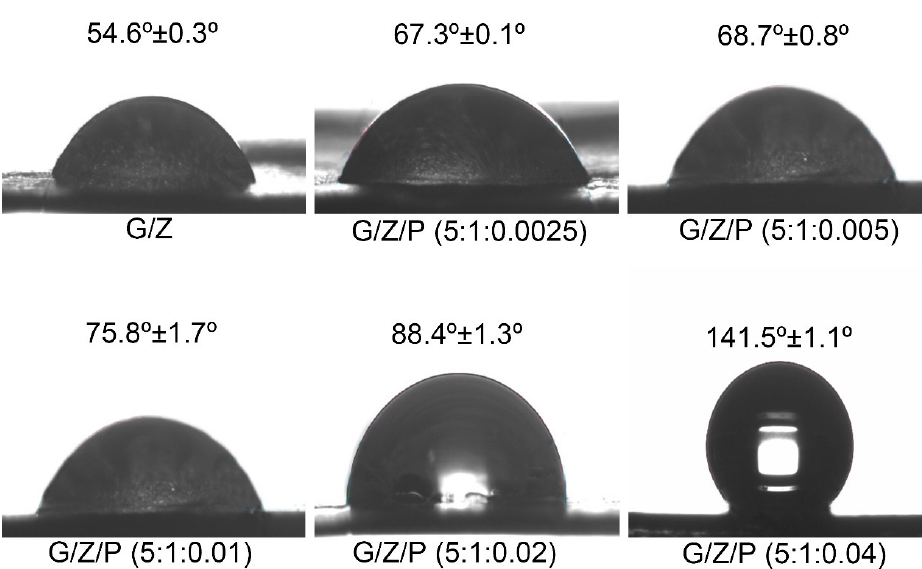
Figure 7. The water contact angle of the gelatin/zein/perillaldehyde nanofiber films.